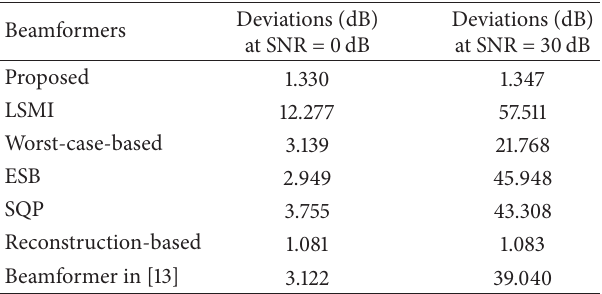
Table 1: Deviations from the optimal SINR for training data size of 𝐾 = 60 and INR = 30